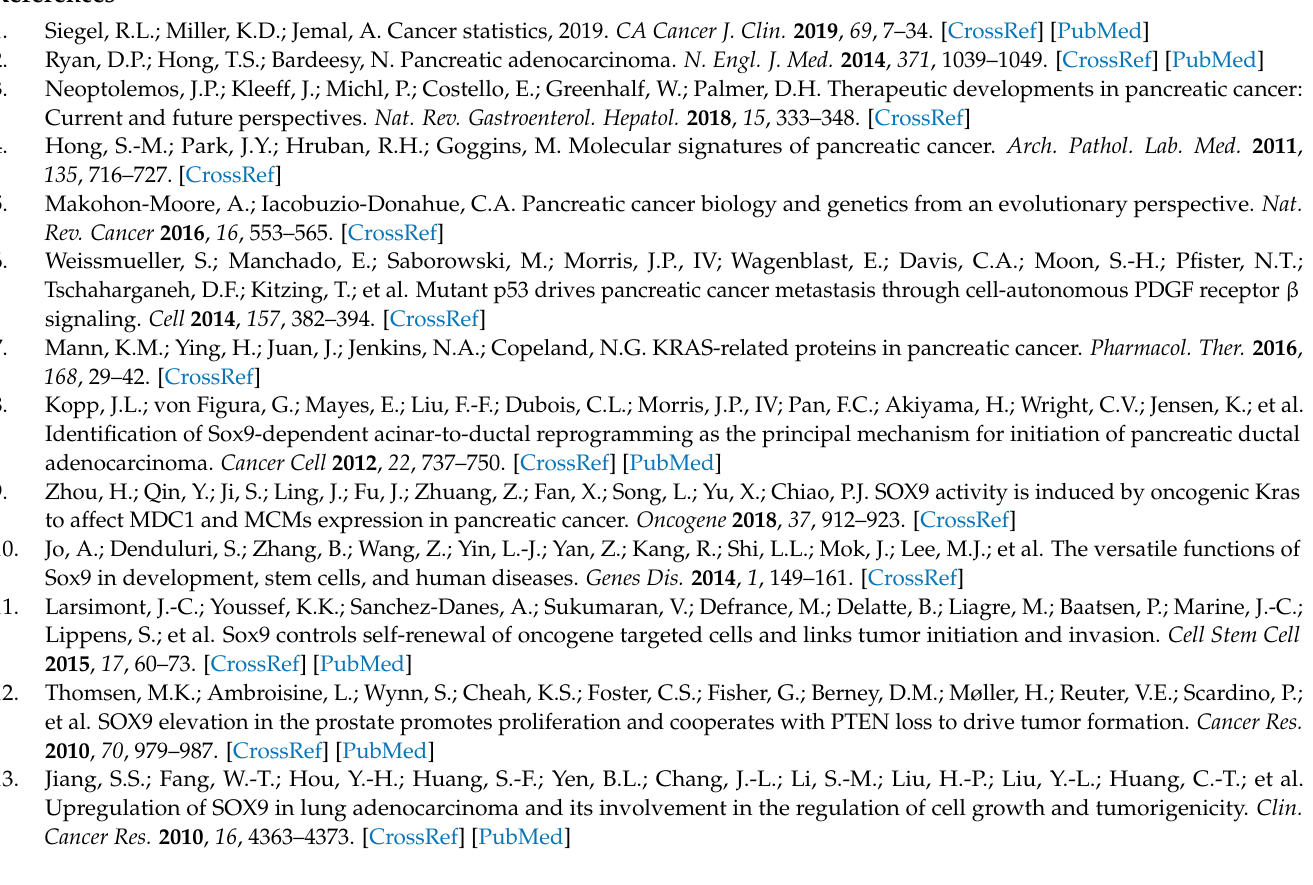
Figure S3: Densitometric quantitation of Western blots from Figure 2A,C,E,G ( n = 3); Figure S4: Densitometric quantitation of Western blots from Figure 3A ( n = 3); Figure S5: The effect of SOX9 downregulation on Panc1 cell proliferation; Figure S6: Expression of SOX9 and EMT markers in pancreatic cancer tumors and cell lines. Table S1: List of the antibodies used for Western Blots and immunofluorescence imaging; Table S2: List of the siRNAs used for targeting human SOX9 RNA; Table S3: List of the primers used for RT-qPCR; Table S4: Results of two independent experiments demonstrated that the downregulation of SOX9 decreased the migratory activity of Panc1-EGFP cells transplanted into Danio rerio